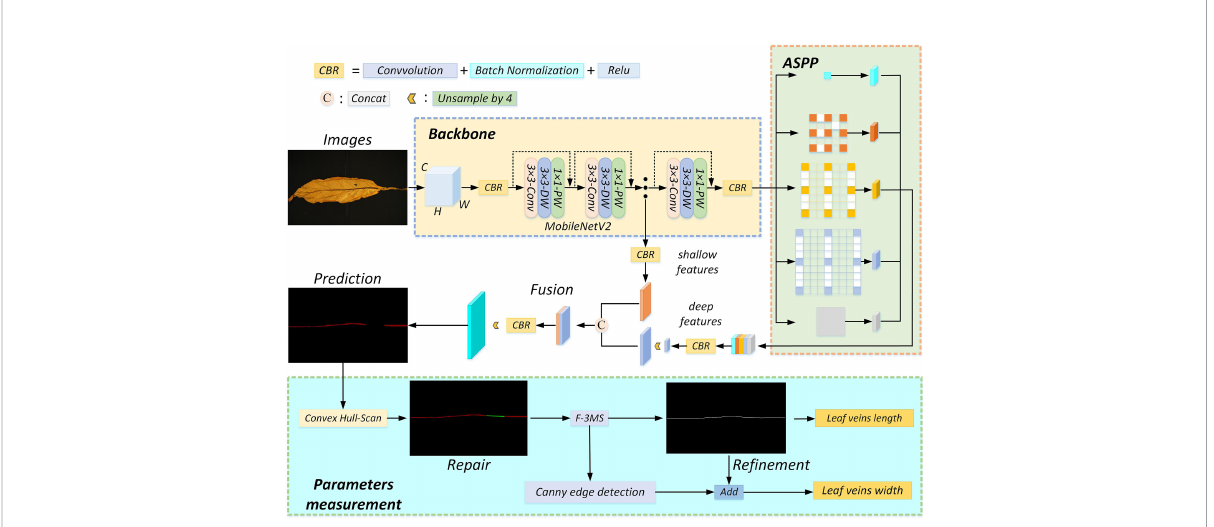
FIGURE 3 The algorithm fl ow chart. The inputted RGB image goes through four processes: feature extraction, occlusion region repair, leaf vein skeleton line extraction, and leaf vein parameter measurement. CBR consists of convolution, batch normalization, and activation function layers. Fusion means “ Concat ” splicing shallow features with deep features. “ Unsample by 4 ” means that the feature map is upsampled by 4, and the model uses 2 upsampling